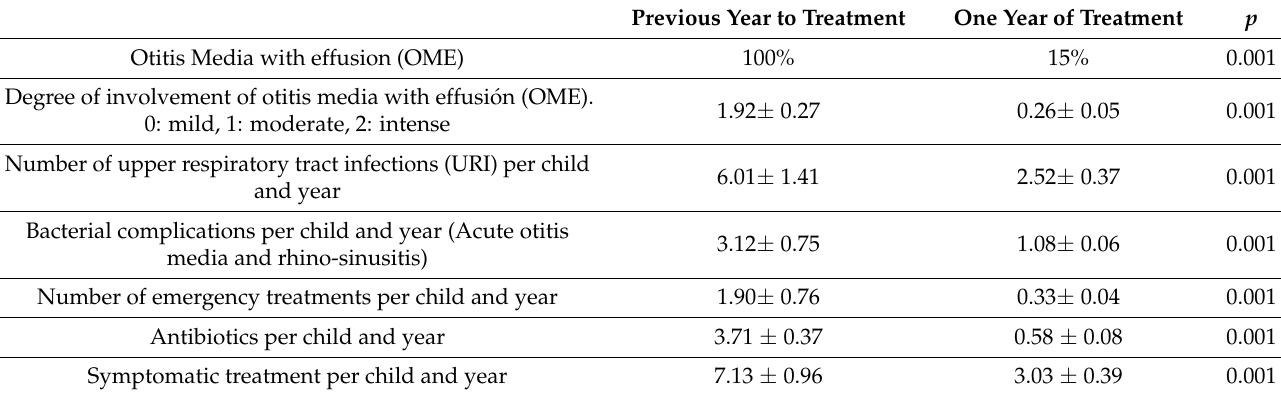
Table 5. Evolution during the previous year and during the year of treatment. Previous Year to Treatment One Year of Treatment p